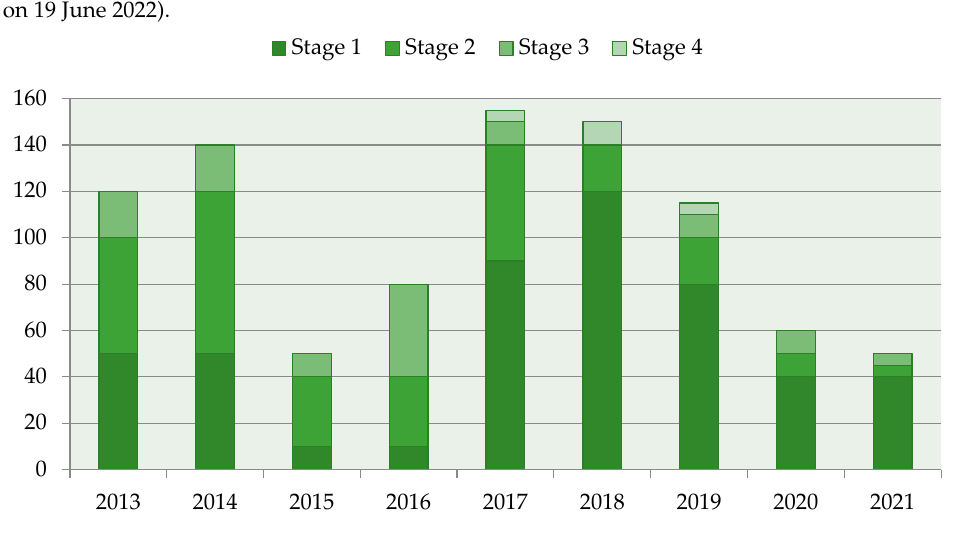
Figure 2. Localization of the ÉcoQuartiers in France with number of ongoing projects per city. Source: http://www.ecoquartiers.logement.gouv.fr/carte-interactive/?vue=map (accessed on 19 June 2022). Table 6. The number of EcoQuartiers through the different stages per year from 2013 to 2021 (May 2022). Source: http://www.ecoquartiers.logement.gouv.fr/20-engagements/chiffres-cles/ (accessed on 19 June 2022).